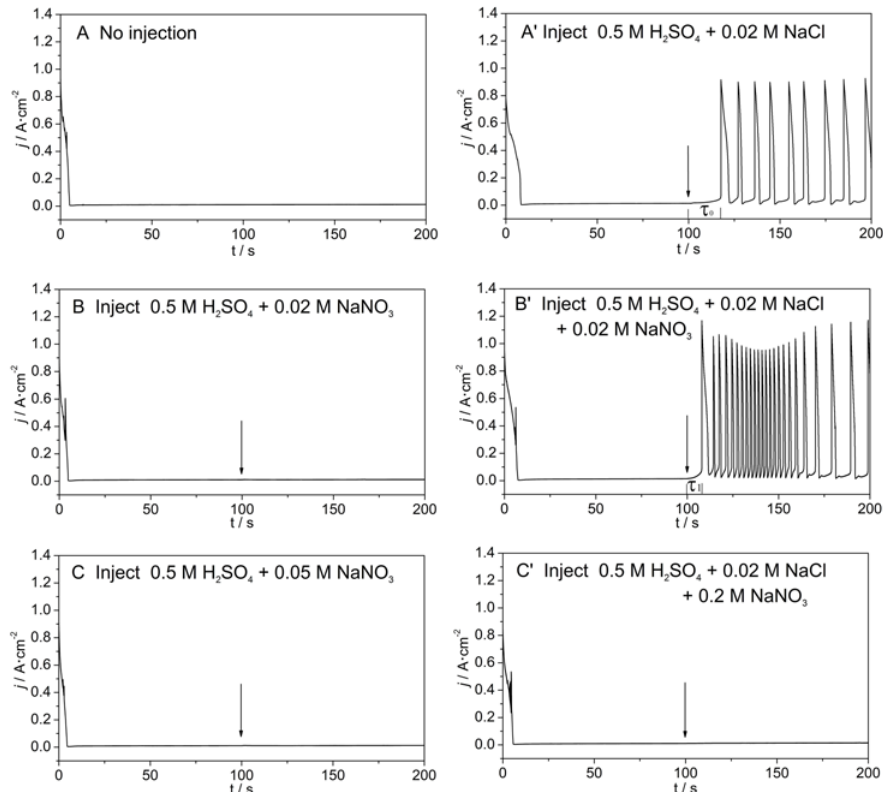
Figure 3. E ff ects of di ff erent injected solutions on the j–t curves of the Fe / 0.5 M H 2 SO 4 system at E = 0.275 V (0.037 mL di ff erent solutions injected at 100 s) ( A ) no injection; ( A’ ) 0.5 M H 2 SO 4 + 0.02 M NaCl; ( B ) 0.5 M H 2 SO 4 + 0.02 M NaNO 3 ; ( B’ ) 0.5 M H 2 SO 4 + 0.02 M NaCl + 0.02 M NaNO 3 ; ( C ) 0.5 M H 2 SO 4